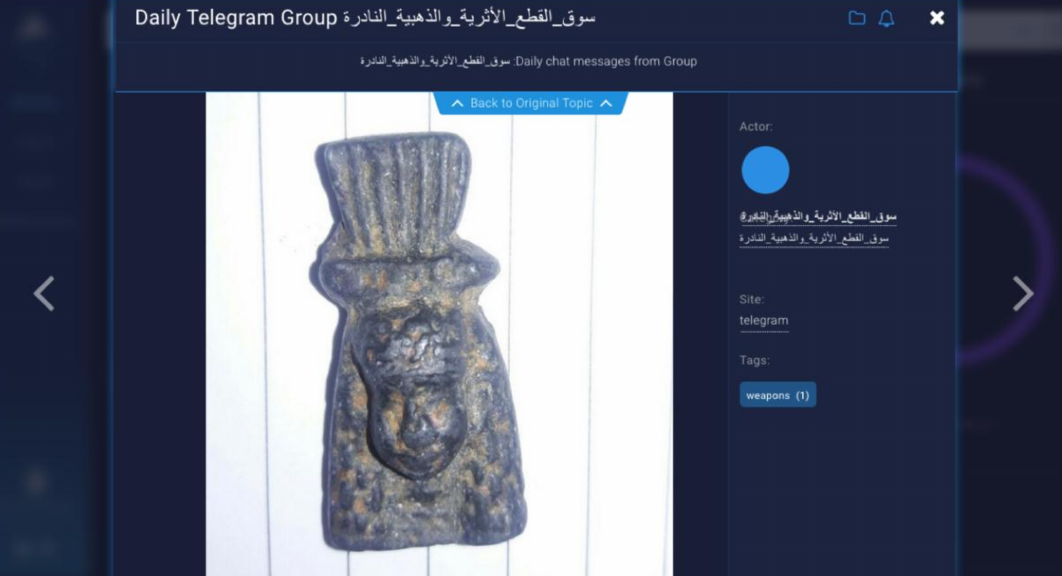
Figure 7. Screen grab of Sixgill platform search that turned up small artifact (authenticity unverified) illicitly offered for sale through a jihadi Telegram communication group. (Screen grab by author